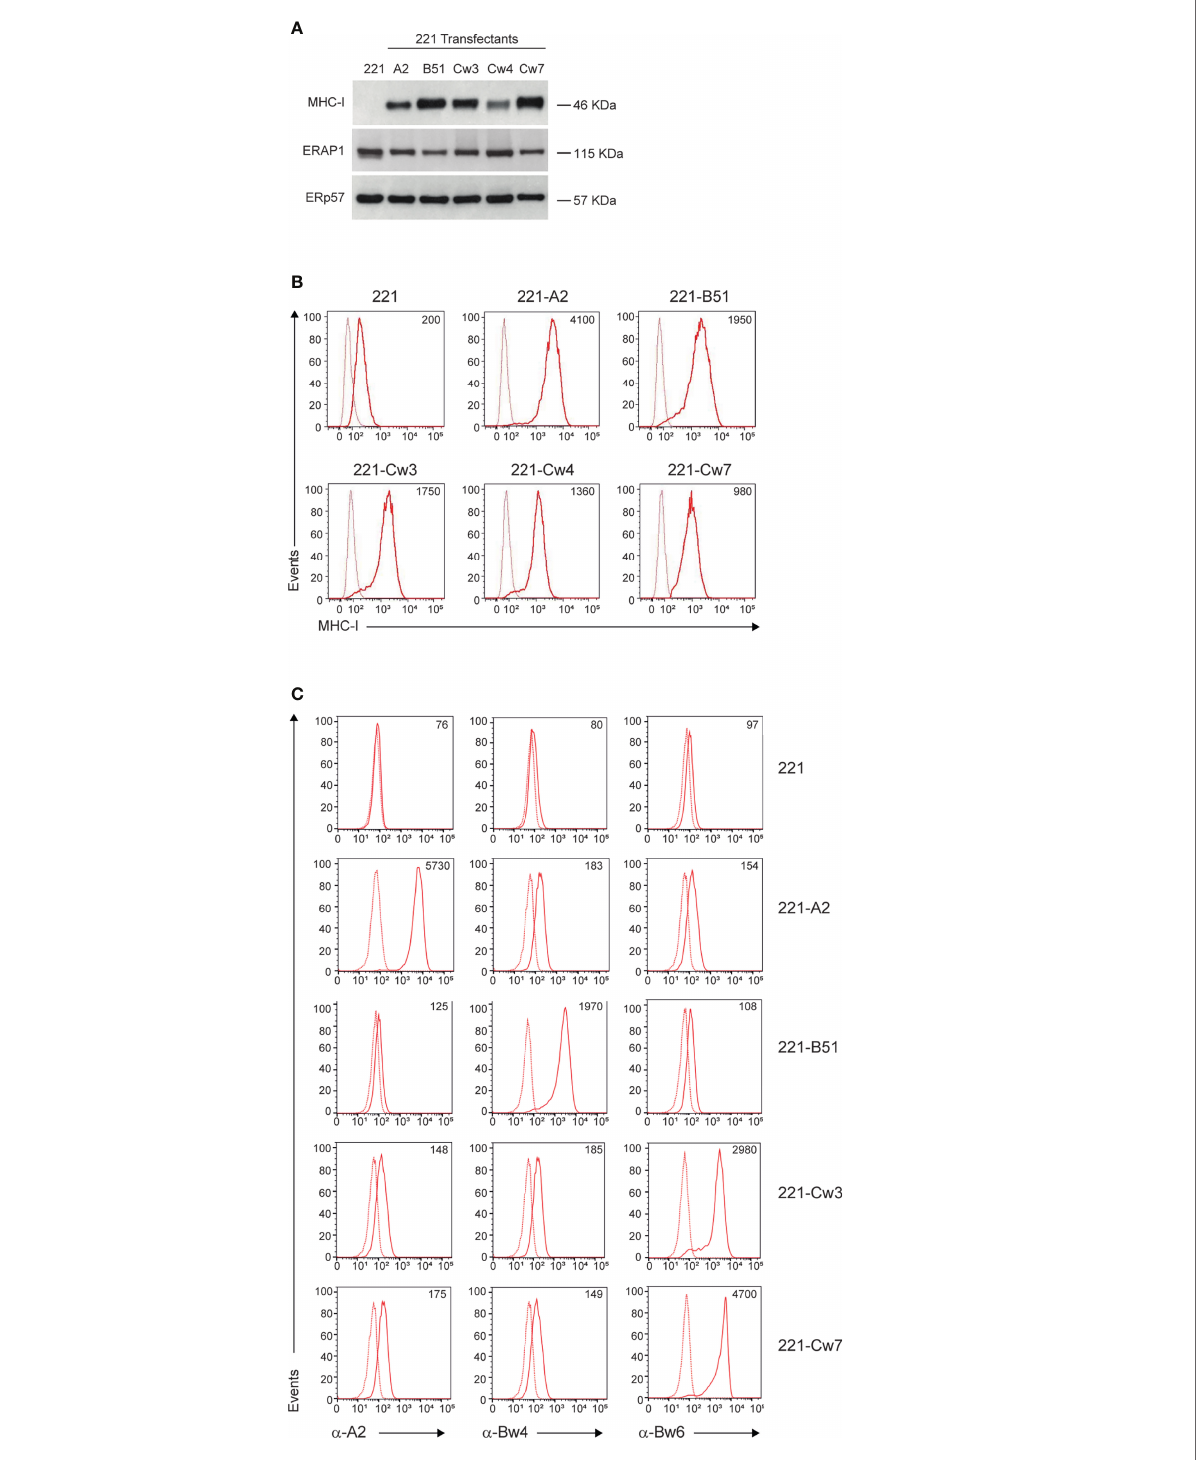
FIGURE 1 | MHC class I and ERAP1 expression in 221 transfectant cells. (A) , Representative immunoblotting analysis of MHC class I and ERAP1 expression in 221 parental and transfectant cells. An ERp57 antibody was used for normalization. (B, C) , Representative fl ow cytometric analyses of HLA class I cell surface expression in the indicated cell lines with the pan-anti HLA class I W6/32 antibody (B) and anti-HLA-A2 (BB7.2), anti-HLA-Bw4 and anti-HLA-Bw6 (C) antibodies. In (B, C) , isotype-matched negative control antibodies are displayed as dotted lines. MFI value for speci fi c antibody staining are